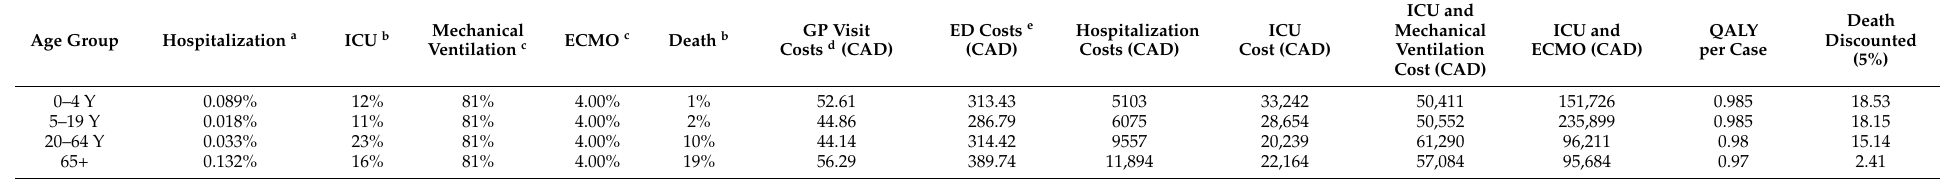
Table 2. Parameters used in the economic model adapted from